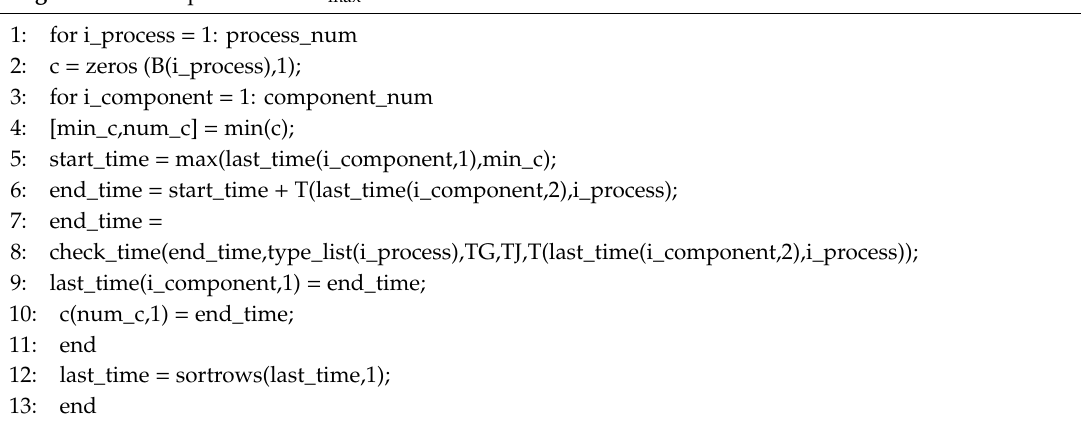
Algorithm 1 Completion time C max